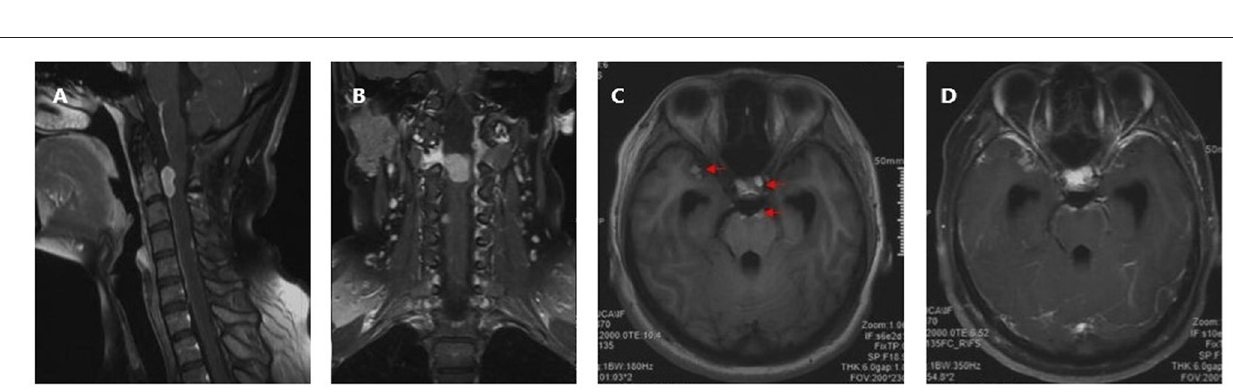
FIGURE 5 | Preoperative head and cervical MRI prior to the second operation. (A) Sagittal contrast-enhanced T1 weighted image. (B) Coronal contrast-enhanced T1 weighted image. (C) Axial T1 weighted image showing intracranial spread (Red arrow). (D) Axial contrast-enhanced T1 weighted image showing metastasis